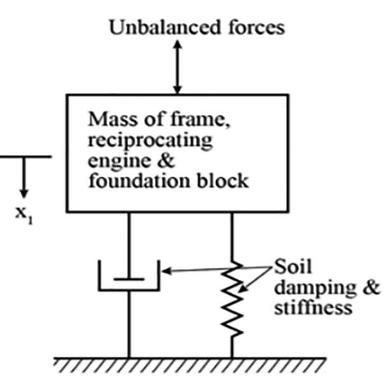
Single DOF diagram.